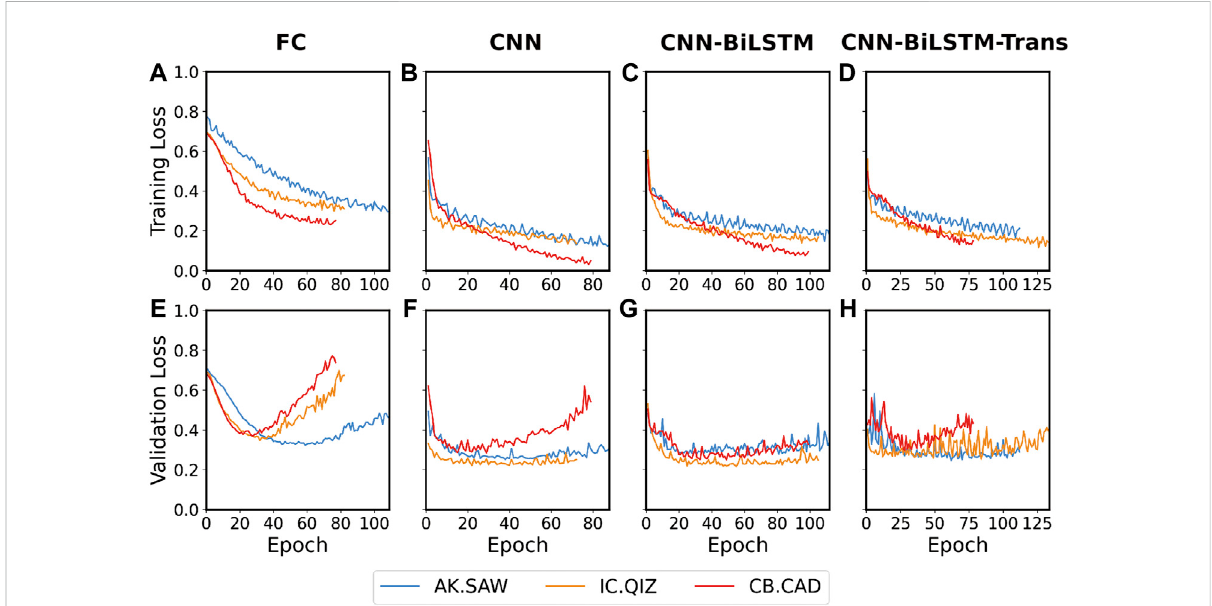
FIGURE 3 Training and validation loss of the four models on training sets of each station. (A,E) FC Model. (B,F) CNN model. (C,G) CNN-BiLSTM Model. (D,H) CNN-BiLSTM-Trans